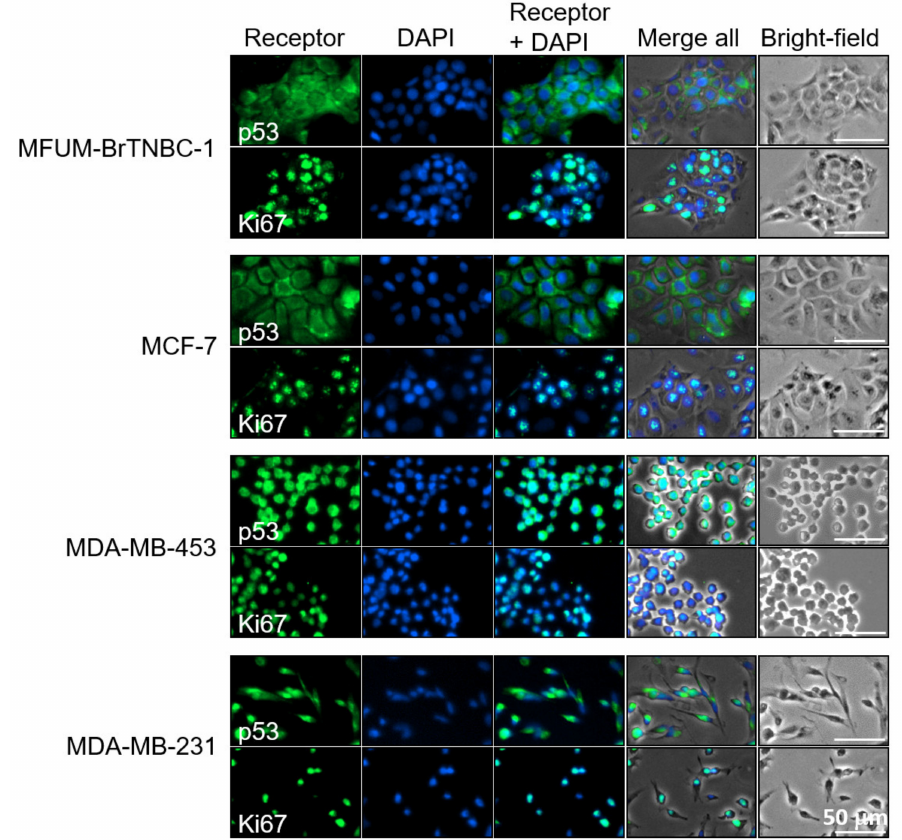
Figure 5. Immunofluorescence staining of p53 and Ki67 in human breast cancer cell lines MFUM- BrTNBC-1, MCF-7, MDA-MB-453 and MDA-MB-231. Legend: Breast cancer cell lines were stained for either p53 (green) or Ki67 (green) and counterstained with DAPI (blue) to visualise the nuclei. The staining was carried out in triplicate for all cell lines and representative images are shown. Scale bar = 50